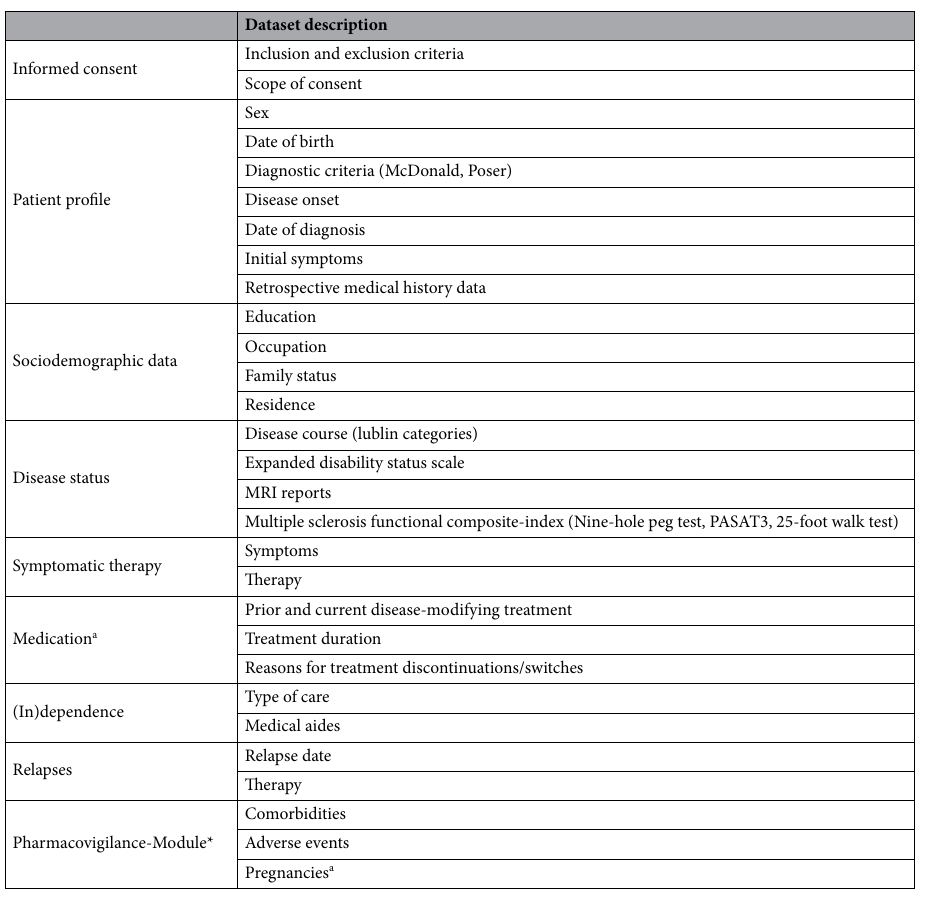
Table 2. GMSR dataset. GMSR German multiple sclerosis registry, PASAT3 paced auditory serial addition test (3 s-interstimulus interval). *Voluntary extended documentation, not collected by default. a The GMSR cooperates with the German MS and child wish registry to allow follow up in more